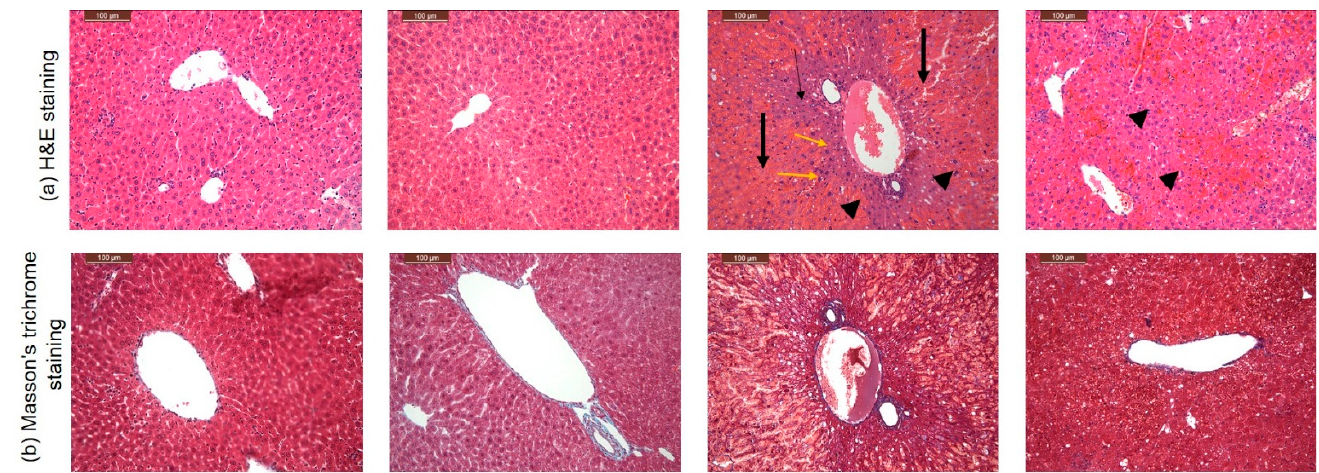
Figure 3. Effects of CARD aqueous (200 mg/kg) extract administration for 15 days prior to APAP administration (300 mg/kg) on histopathological changes in the hepatic sections stained with ( a ) hematoxylin and eosin (H&E) and ( b ) Masson’s trichome staining in APAP induced acute hepatic failure in mice.